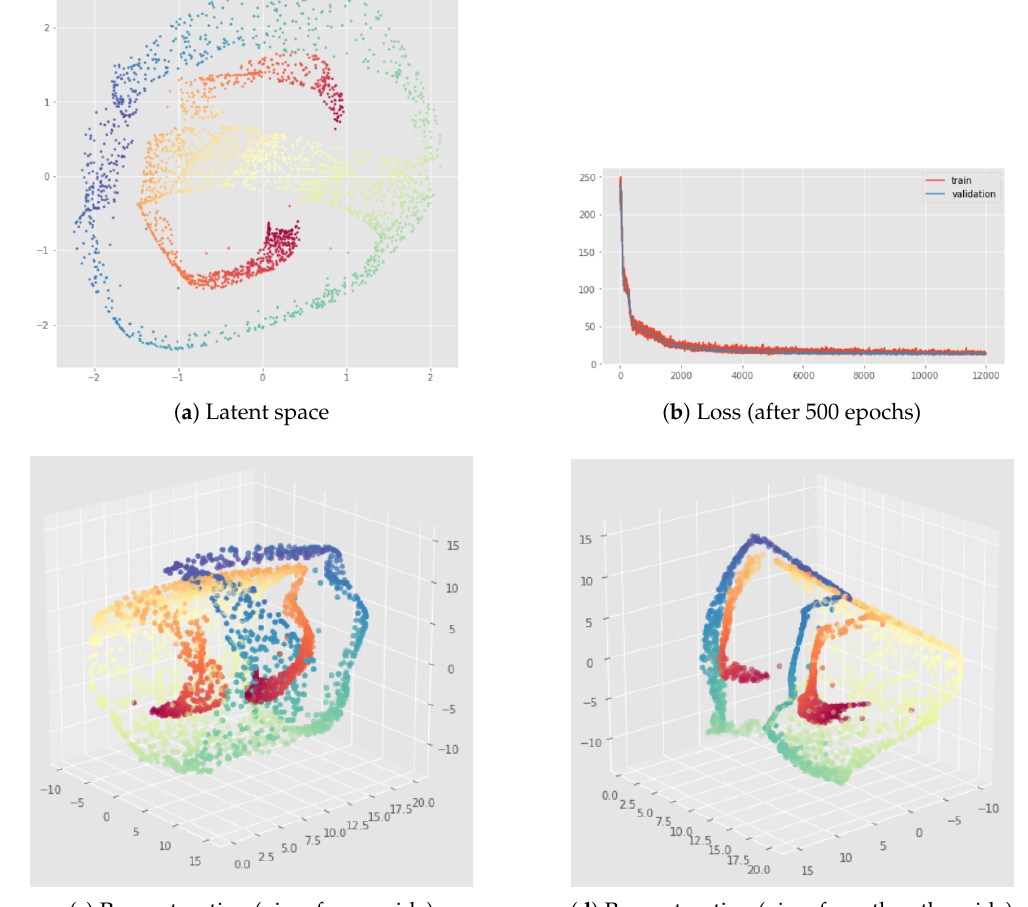
Figure 12. Latent representation (top left) and reconstruction (down) of the Standard VAE applied to the swissroll - pytorchseed = 1, trained for 500 epochs. We can see that after 500 epochs, for the latent representation ( a ) we have β 1 = 2 whereas it is equal to 0 for the original swissroll dataset. Moreover, we can visualize a discontinuity in the latent representation ( a ) for all the colors except for the yellow region. This discontinuity is retrieved again for the reconstruction as seen in ( c , d ).